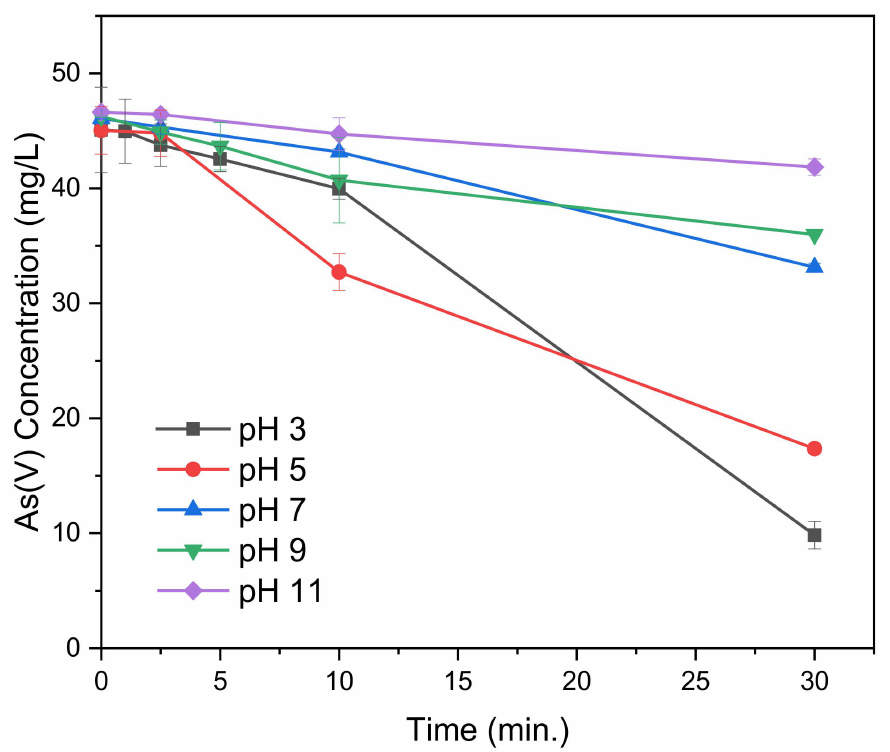
Figure 3. As(V) concentration over time during electrocoagulation at various